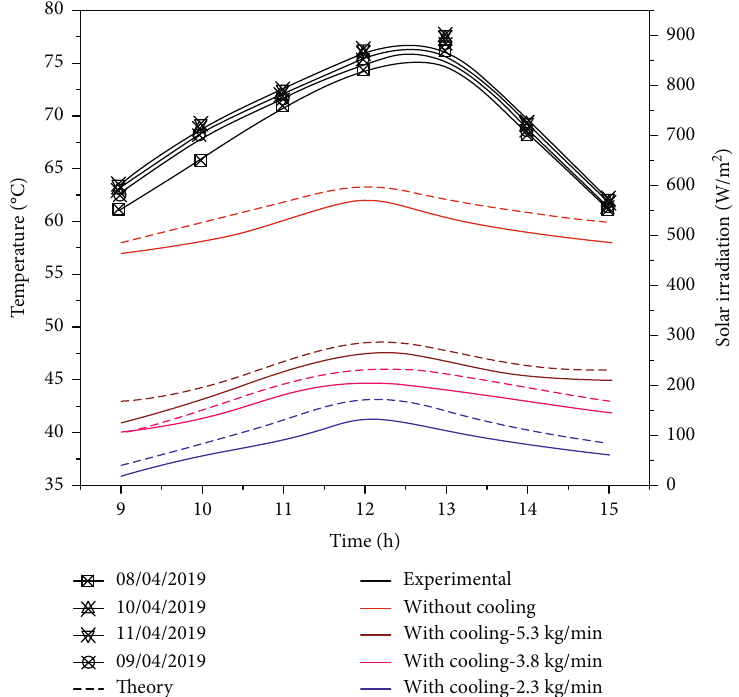
Figure 4: Temperature responses on di ff erent cooling